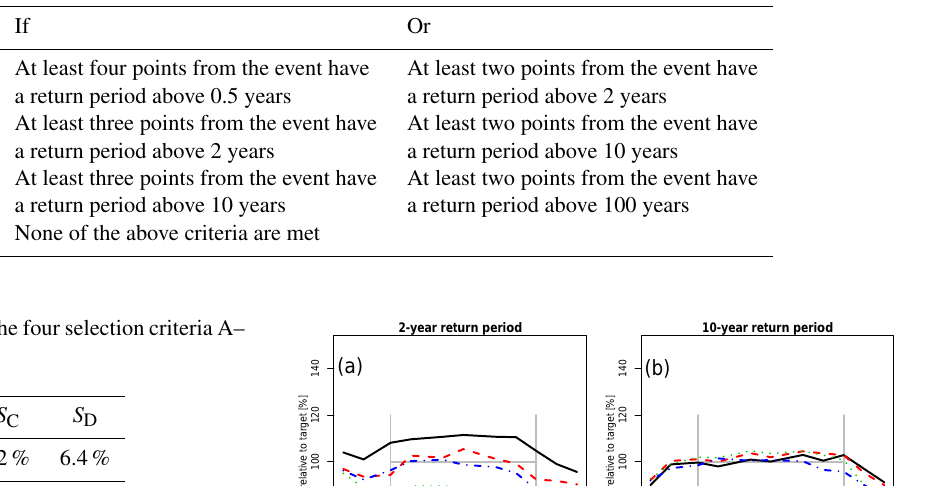
Table 5. Selection criterion S D for choosing T event s at event level.